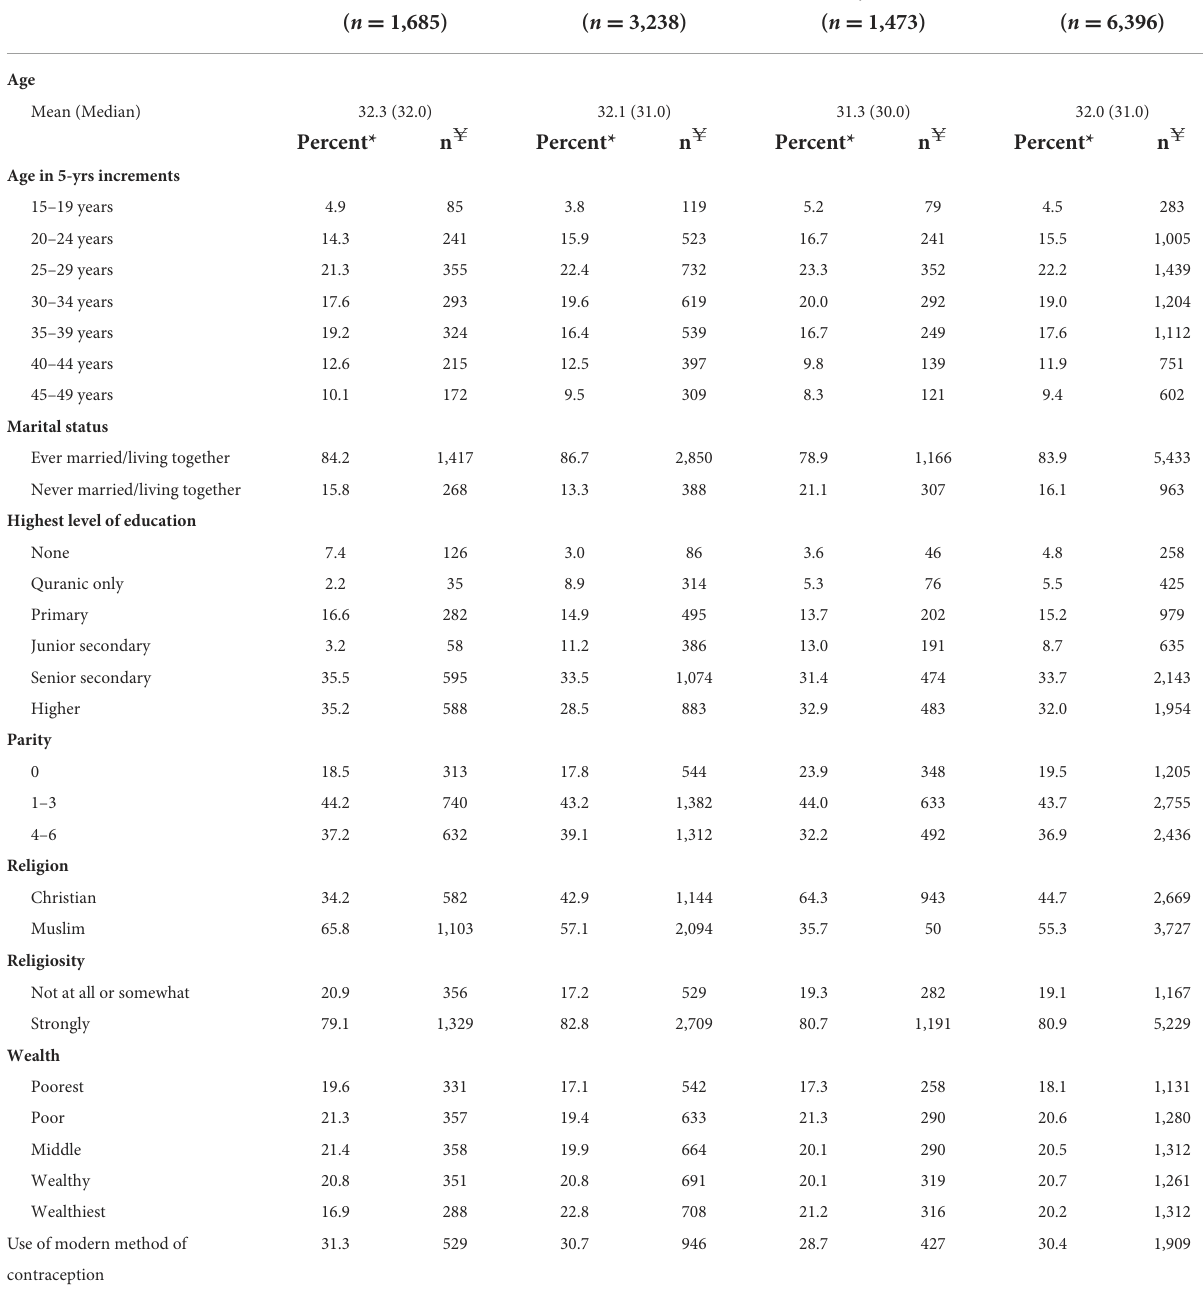
Percentagesareadjustedforthedesignofthesurvey. *Weightedpercent. U